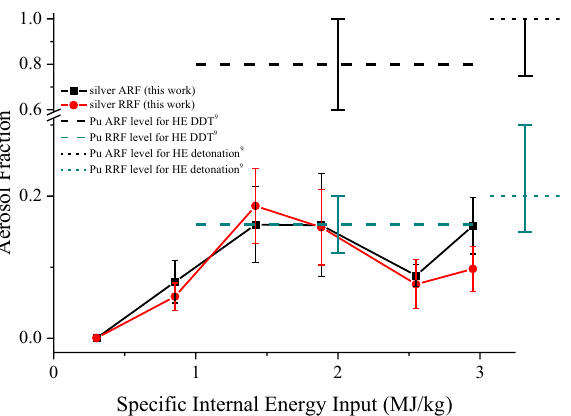
Figure 8. Aerosol release fraction and respirable release fraction of silver aerosol versus specific internal energy input. The ARF and RRF of plutonium with their upper and lower limits for both full and lower order detonation conditions in Stephens’ work 9 (indicated by dashed or short dashed horizontal lines) are included for